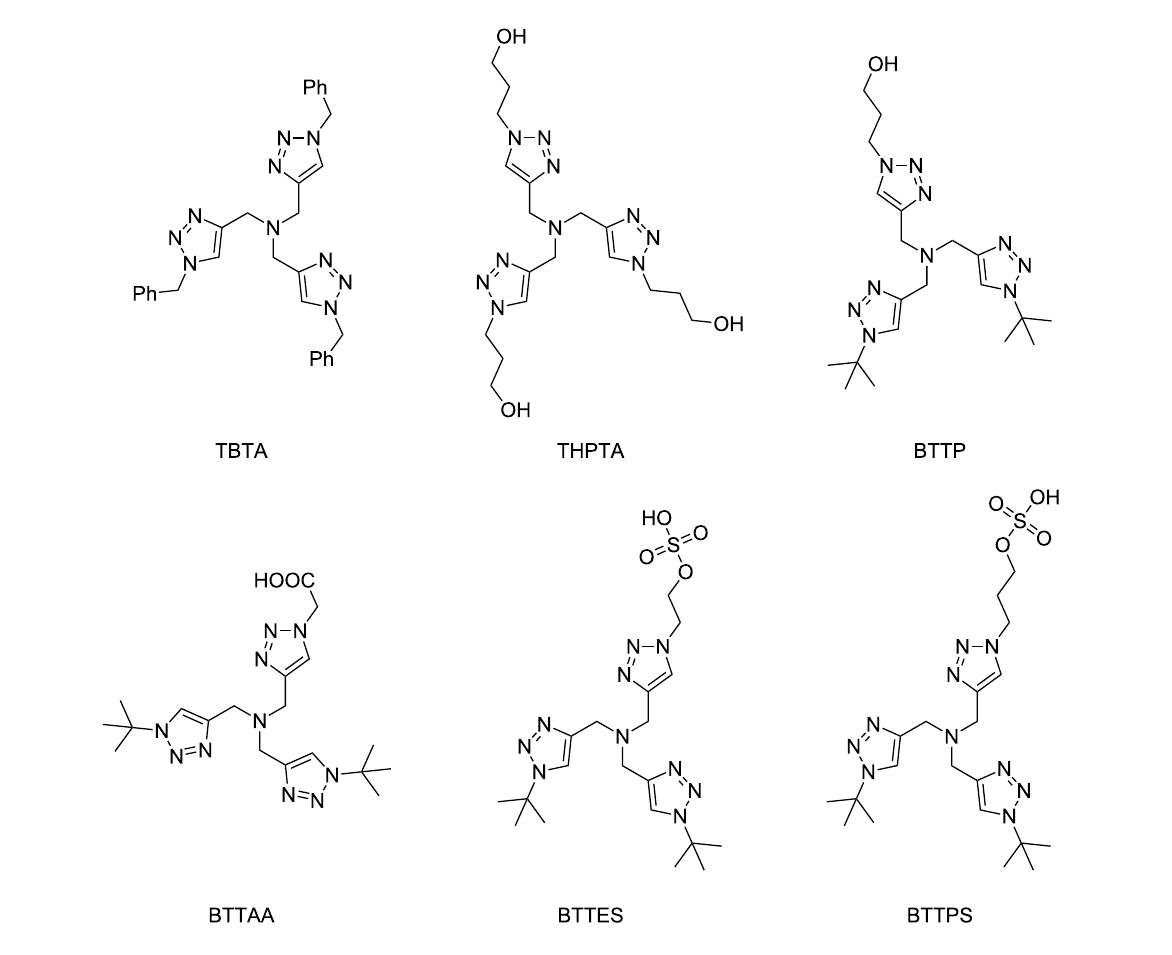
Figure 1: Tris(triazolylmethyl)amine ligands for CuAAC applications in bioorganic chemistry: TBTA = tris[(1-benzyl-1 H -1,2,3-triazol-4-yl)methyl]amine [45,63,64]; THPTA = tris[(1-hydroxypropyl-1 H -1,2,3-triazol-4-yl)methyl]amine [70-78]; BTTP = 3-[4-{(bis[(1- tert -butyl-1 H -1,2,3-triazol-4- yl)methyl]amino)methyl}-1 H -1,2,3-triazol-1-yl]propanol [79]; BTTAA = 2-[4-{(bis[(1- tert -butyl-1 H -1,2,3-triazol-4-yl)methyl]amino)methyl}-1 H -1,2,3- triazol-1-yl]acetic acid [74]; BTTES = 2-[4-{(bis[(1- tert -butyl-1 H -1,2,3-triazol-4-yl)methyl]amino)methyl}-1 H -1,2,3-triazol-1-yl]ethyl hydrogen sulfate